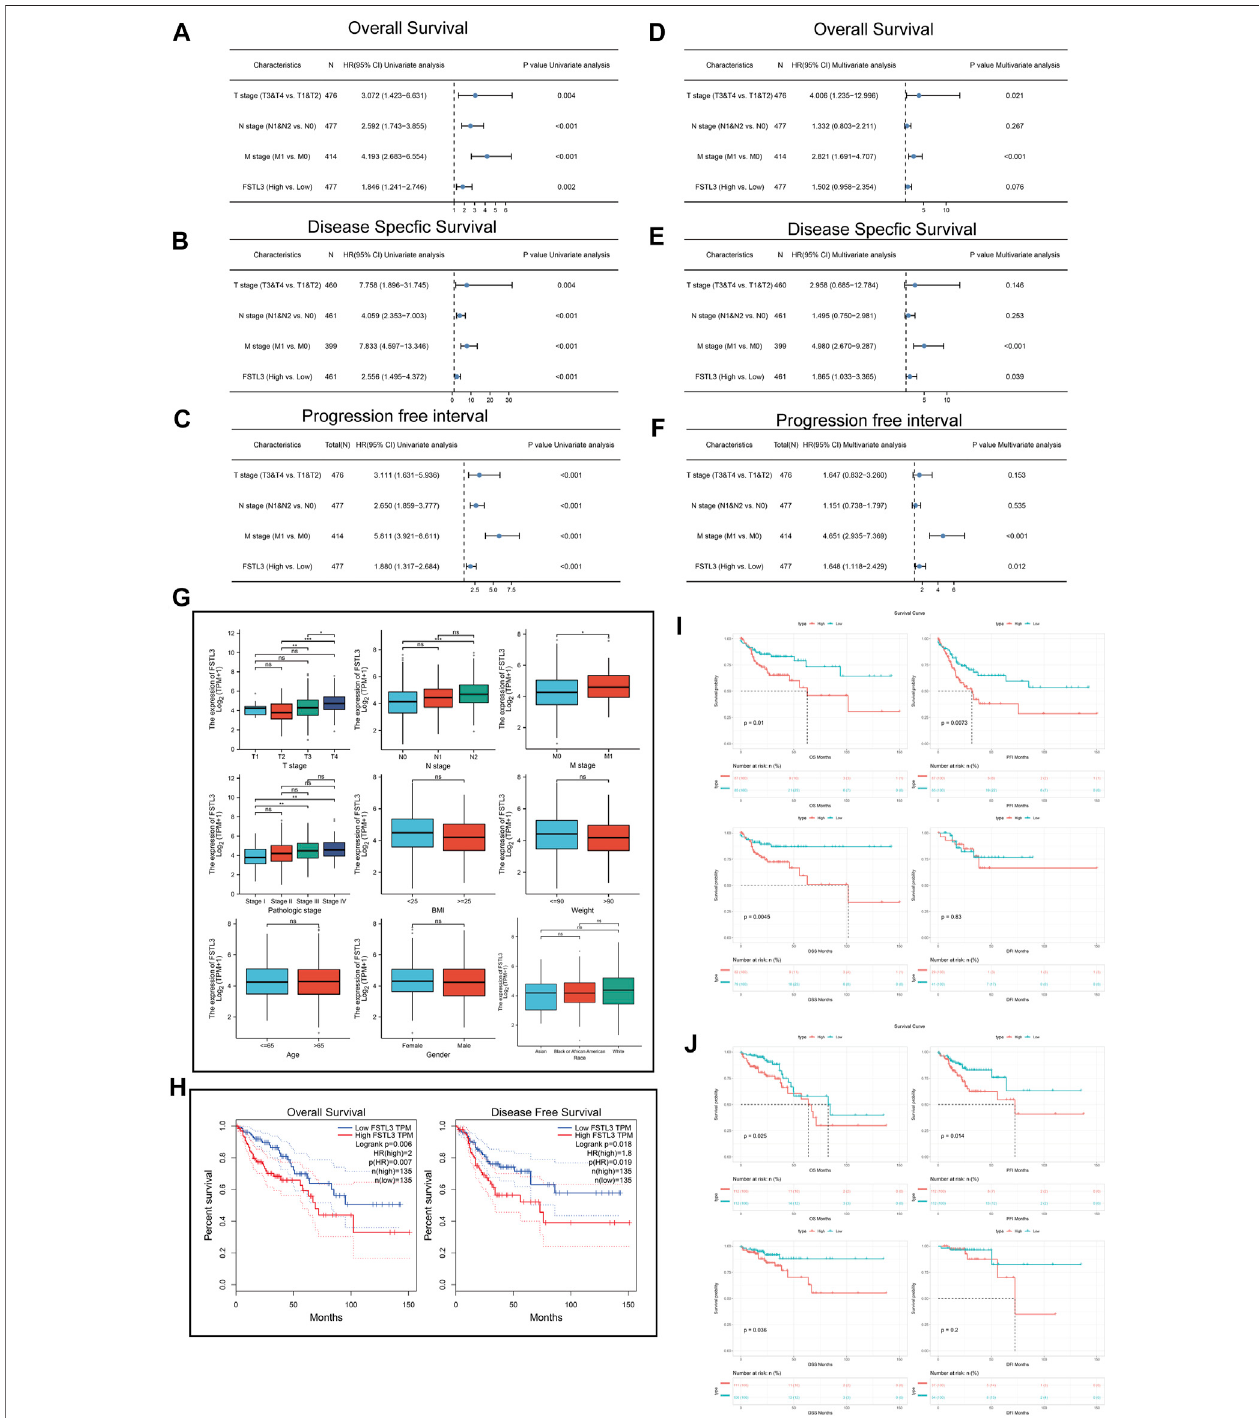
FIGURE 2 | Univariate and multivariate Cox regression analyses of FSTL3 expression and clinicopathological factors related to the prognosis of colorectal cancer (CRC). (A – C) Univariate Forest plot illustrating FSTL3 expression and the clinicopathological factors related to the (A) Overall Survival(OS), (B) Disease-Speci fi c Survival (DSS), and (C) Progression Free Interval (PFI) in CRC. (D – F) Multivariate Forest plot showing FSTL3 expression and the clinicopathological factors related to (D) OS, (E) DSS, and (F) PFI in CRC. (G) Association of the FSTL3 mRNA expression with the T/N/M stage, pathological stage, BMI, weight, age, sex, and race. (H) Overall survival (OS) and Disease-free survival (DFS) from the GEPIA database. (I,J) The OS, disease-free interval (DFI), DSS, and PFI from The Cancer Genome Atlas-COAD databasebasedonthe FSTL3 expressionlevels. (I) KRASmutated; (J) KRASwild-type.Hazardratiosand p -valuesareshown.NS:notsigni fi cant, * p < 0.05, ** p < 0.01, *** p <